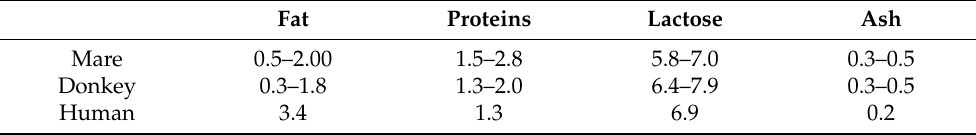
Table 3. Chemical composition of mare, donkey and human milk (g/100